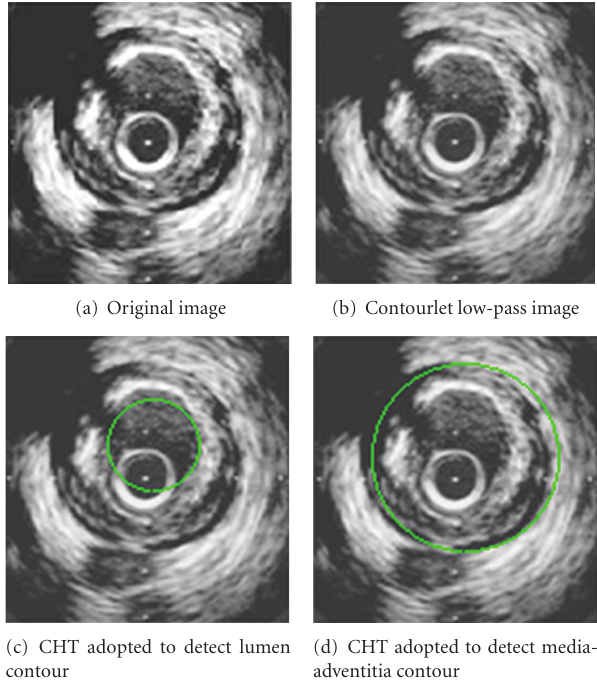
Figure 3: Initial contour